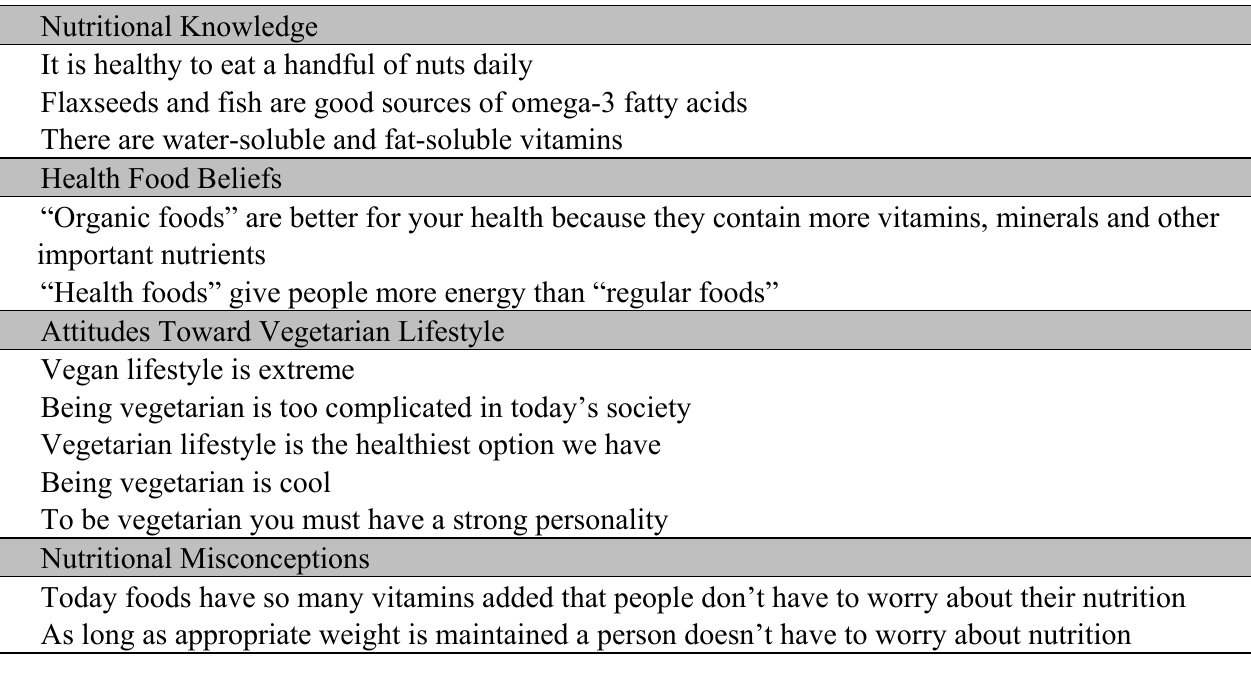
Table 1. Selected questions used to assess nutritional knowledge, health food beliefs, attitudes toward vegetarian lifestyle and nutritional